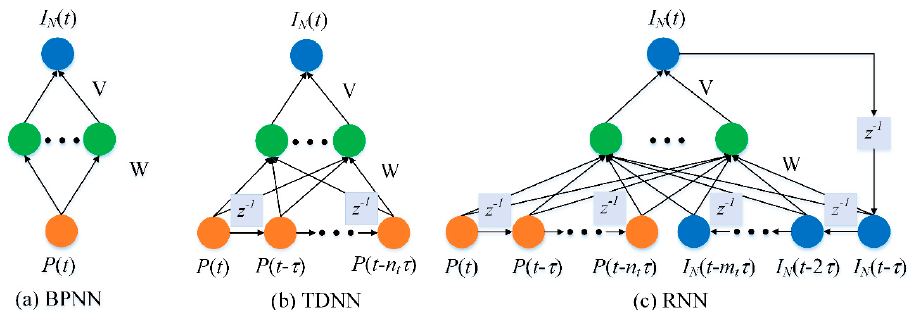
Figure 3. Architectures of ( a ) the back propagation neural network (BPNN), ( b ) the time-delay neural network (TDNN) and ( c ) the recurrent neural network (RNN) ( z − 1 represents the time-delay unit, V and W are weight connections for linking neurons).